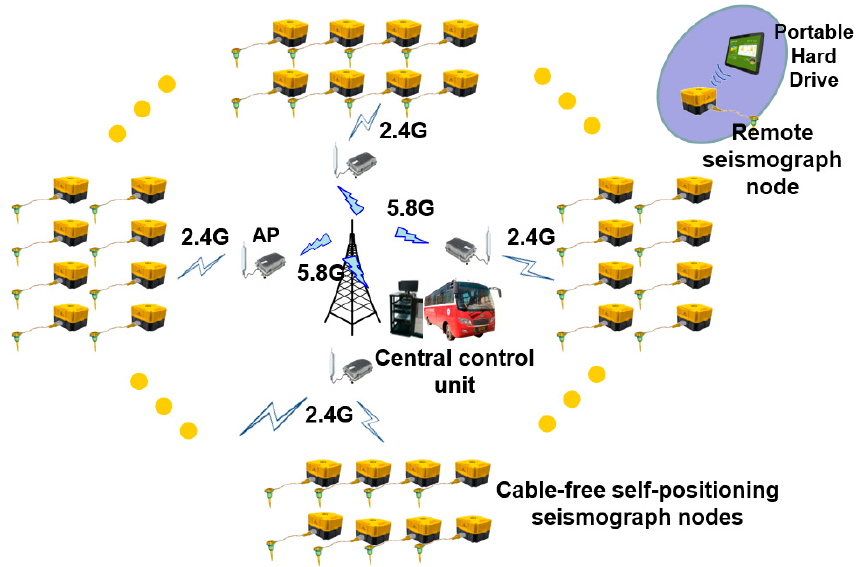
Figure 1. Cable-free self-positioning seismic exploration system architecture.